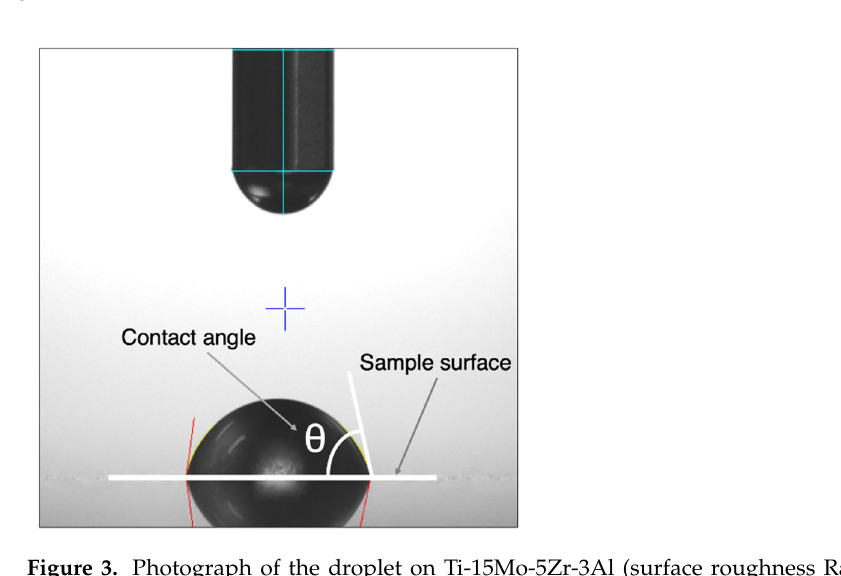
Figure 2. Photograph of the surface using a laser scanning wide-area 3D measurement system (VR-5000; KEYENCE Co., Osaka, Japan) (original magnification × 160).